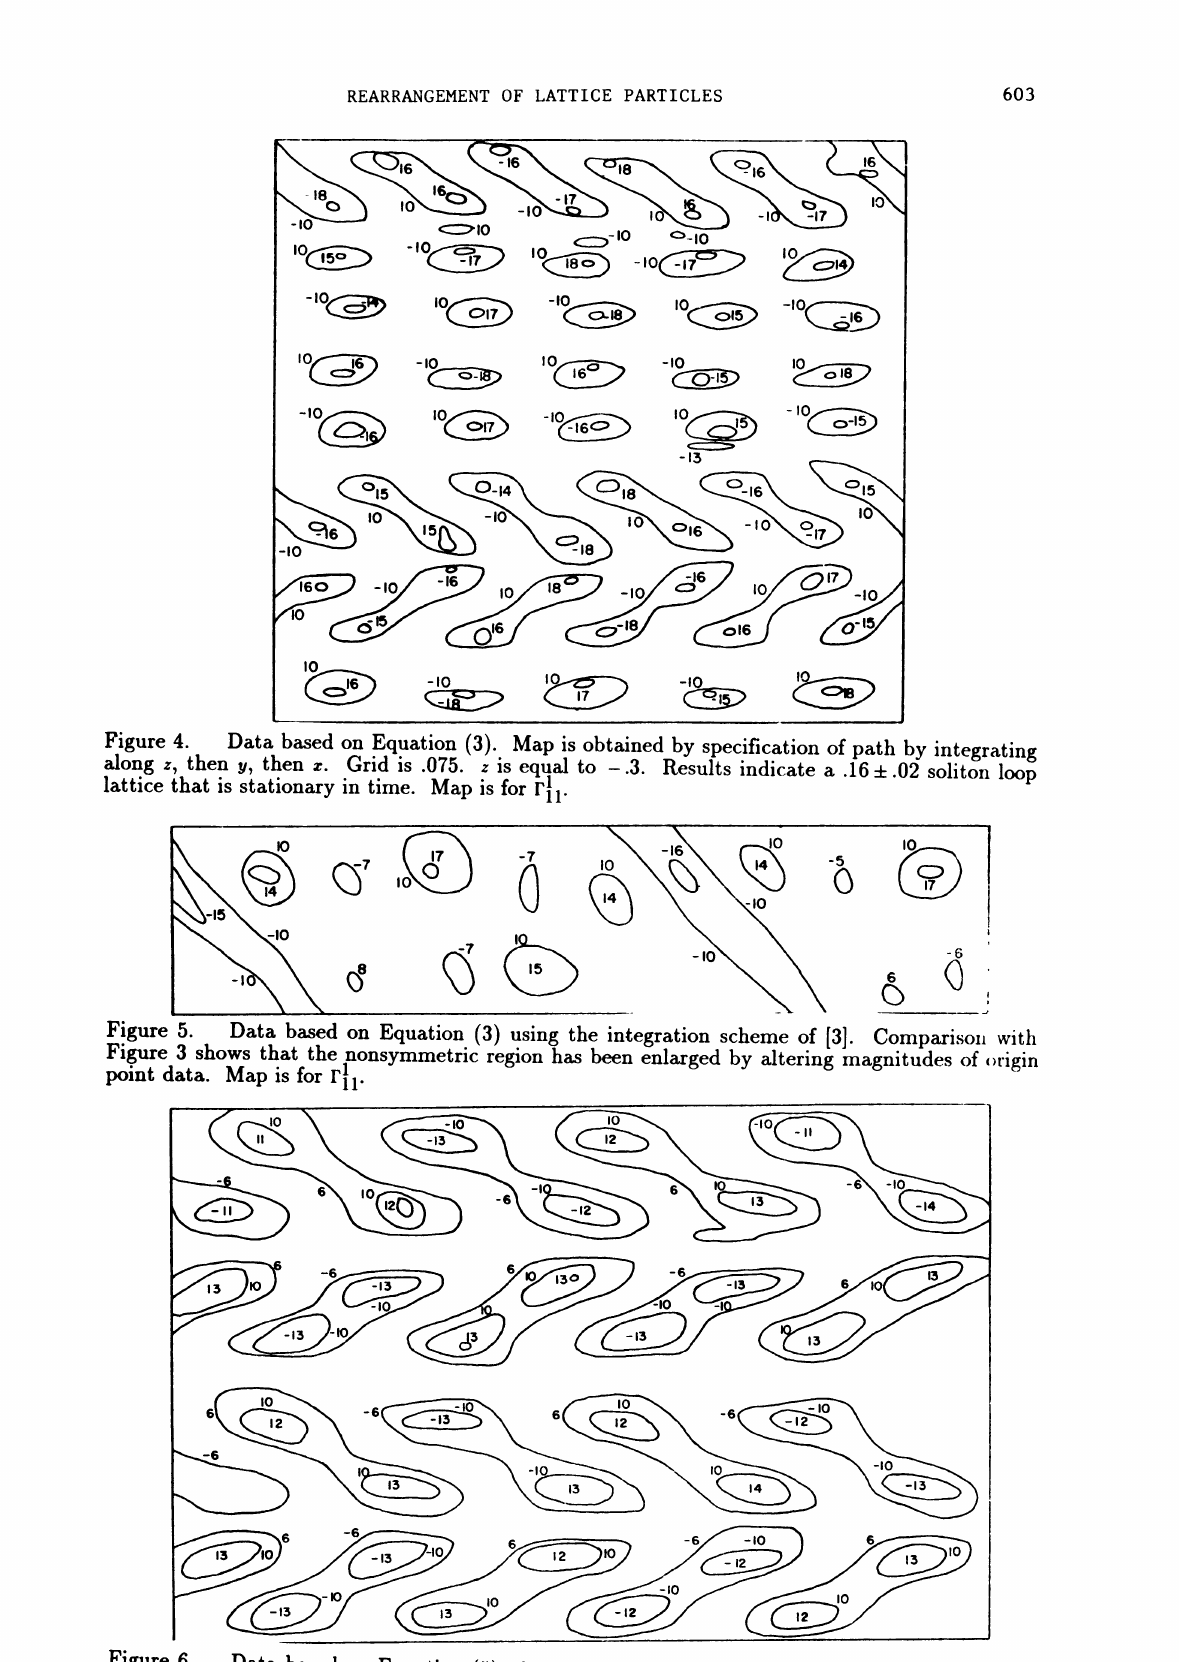
is obtained by specification of path. Grid is .15. a soliton loop lattice that is stationary in time of magnitude